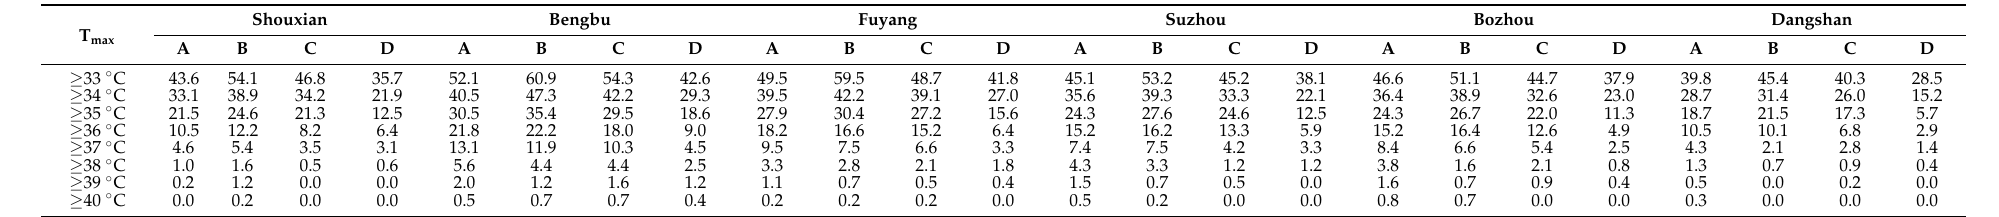
Table 4. The occurrence probability (%) of heat stress in four phases, i.e., pre-anthesis (A, 15–24 July), anthesis (B, 25–31 July), silking (C, 1–7 August), and post-silking (D, 8–15 August), around maize flowering in six selected sites, i.e., Shouxian, Bengbu, Fuyang, Suzhou, Bozhou, and Dangshan, on Huaibei Plain,